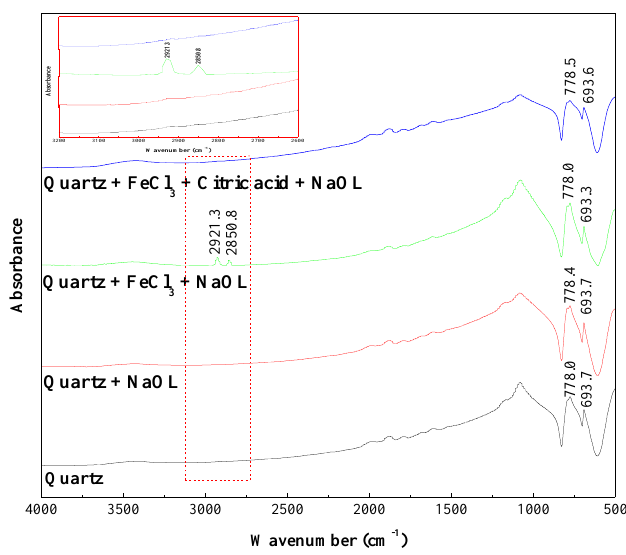
Figure 5. FTIR analysis of kyanite.